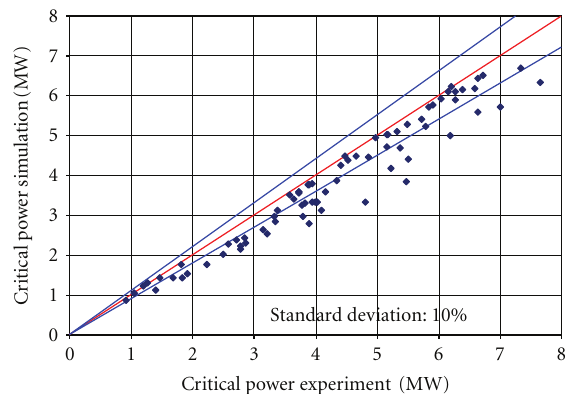
Figure 18: Measured and simulated critical power values for assem- bly A2.